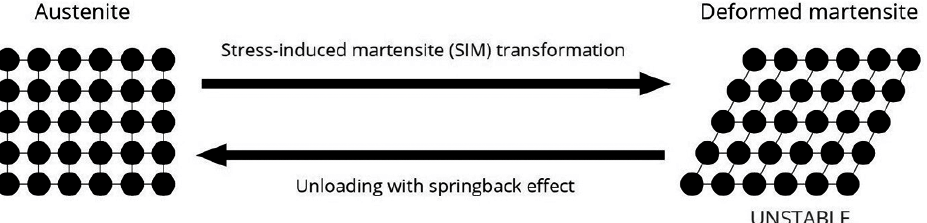
Figure 1. Demonstration of superelasticity (SE) through stress-induced martensite transformation (SIM) within 8% elastic deformation. The martensite is in an unstable monoclinic lattice structure and returns to its austenitic state upon the unloading of stress.